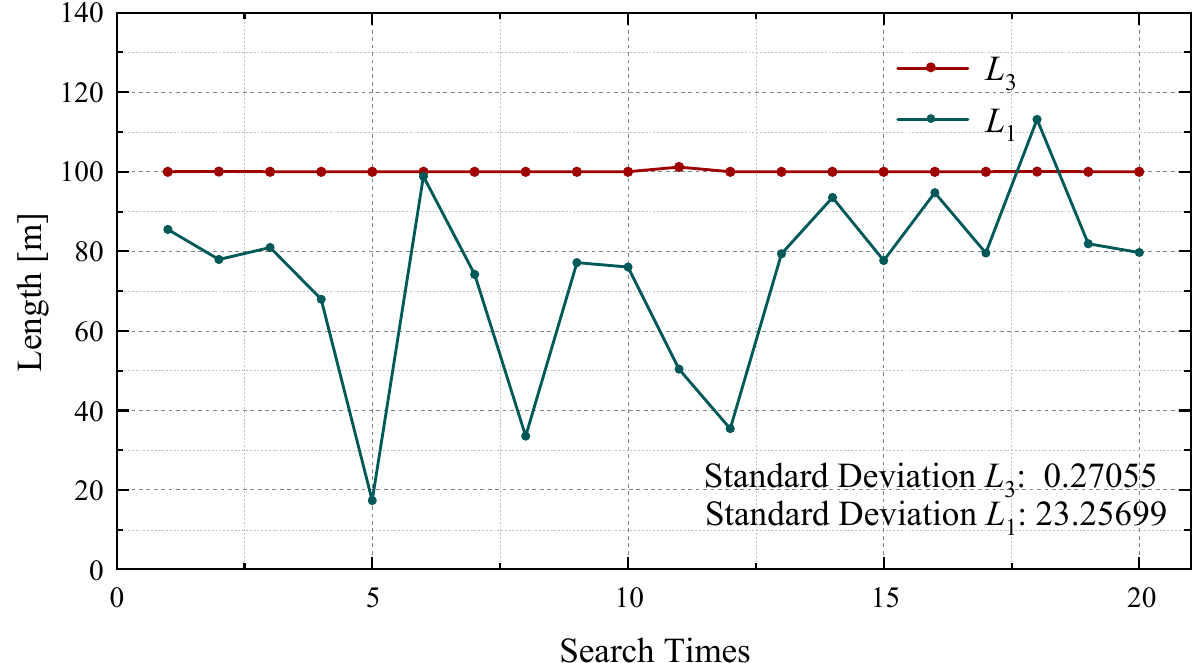
Figure 12. The fluctuations of L 1 and L 3 for 20 calculations. Wi ś niowski et al. [19] suggested fixing the length of the central segment L rowing the ranges of the other parameters to further optimize the five-segment trajectory